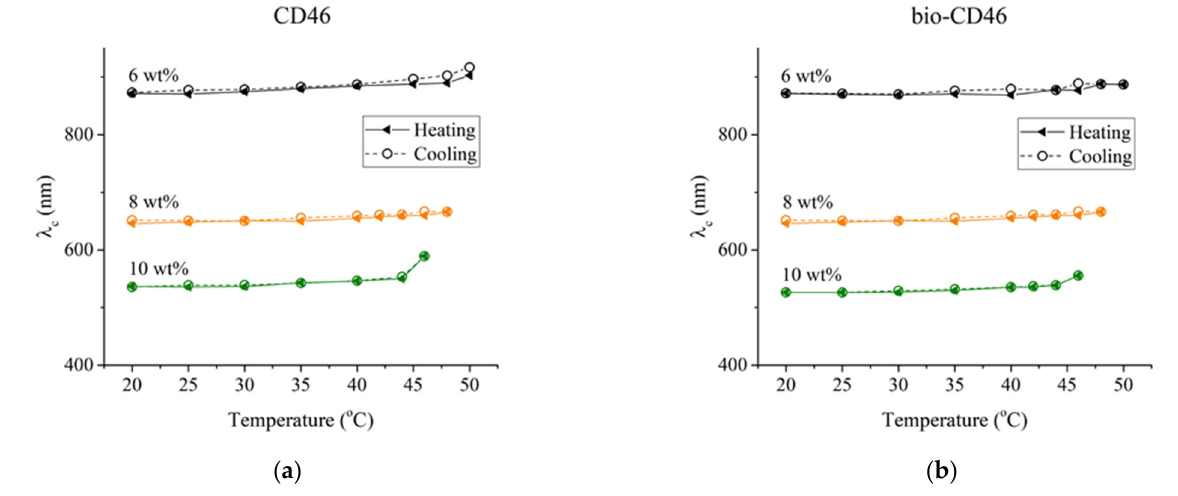
Figure 4. Temperature dependence of the reflective bandgap central wavelength λ c location for ( a ) CD46 and ( b ) bio-CD46 mixtures. Both nematic-chiral dopant mixtures showed low temperature sensitivity. Close to the nematic–isotropic transition temperature, a red shift of the bandgap is observed due to cholesteric helix unwinding.